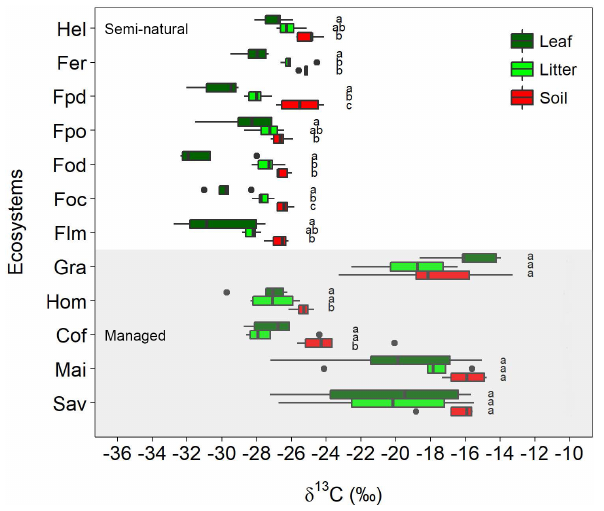
Figure 2. Variation in δ 13 C values for leaves, litter, and soil along the Kilimanjaro elevational and land-use gradient. Ecosystem data represent the average values of five sites (one per each transect), with each site being composed of five samples ( n = 5). Box plots show median values per ecosystem with whiskers representing the first and third quartiles. Dots represent outliers. The shaded re- gion represents managed ecosystems (both intensively and exten- sively), while those unshaded indicate semi-natural ecosystems. Lower-case letters show significant differences between sampled materials within each ecosystem (one-way ANOVA followed by Tukey’s HSD test as a post hoc procedure, P ≤ 0 . 05). The ecosys- tem acronyms used are as per Table 1. Mai, Cof, and Hom are man- aged cropping sites, Gra and Sav are extensively managed grass- lands and savannas, and the rest represent semi-natural ecosystems. Sites are ordered by increasing altitude.